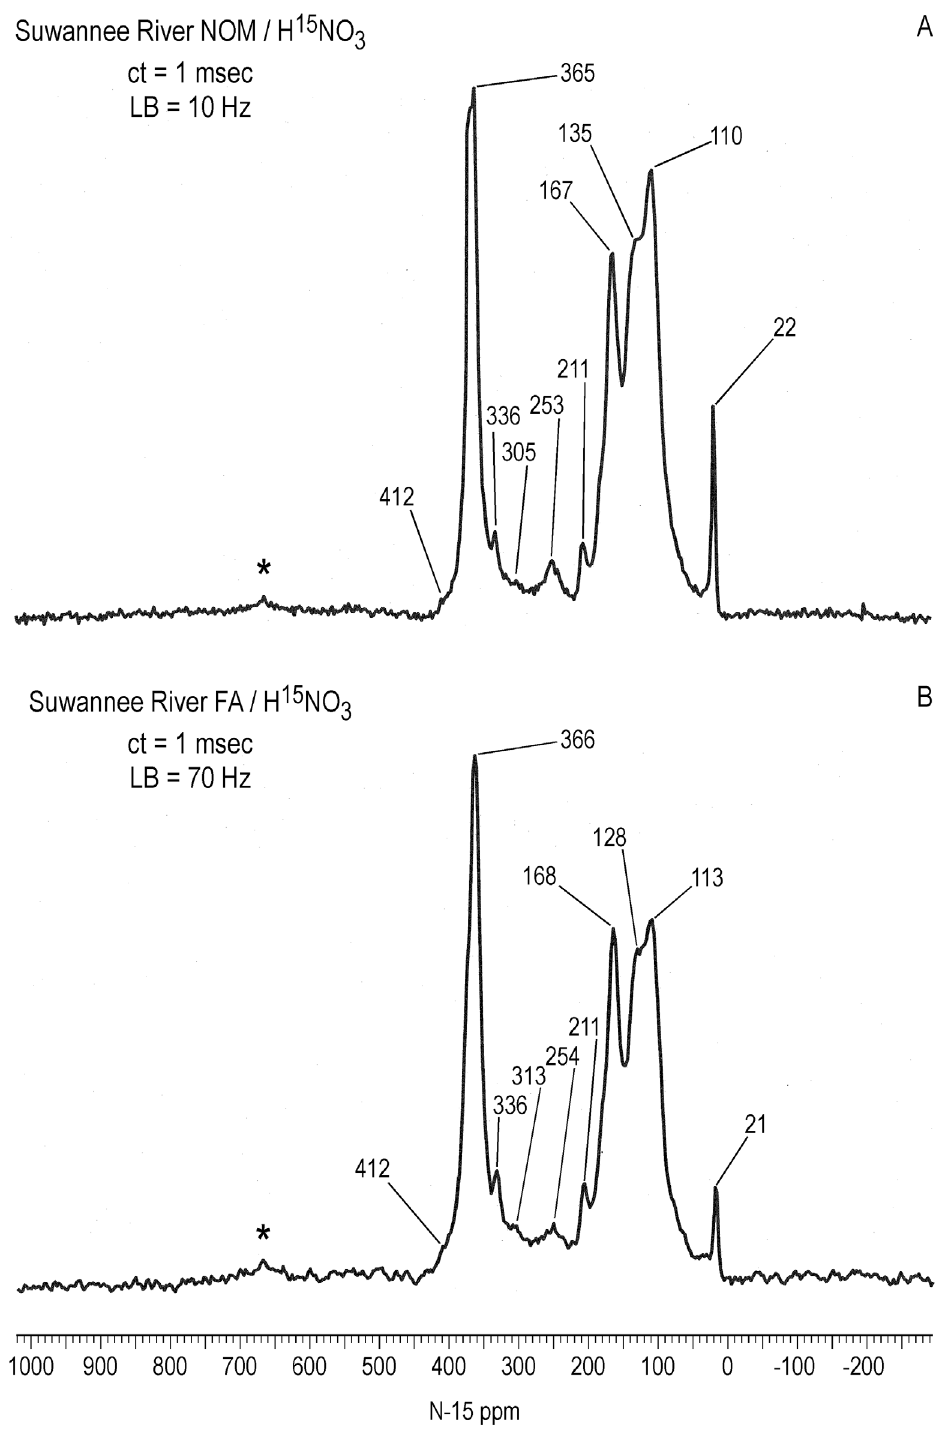
Fig 6. Solid state CP/MAS N-15 NMR spectra of Suwannee River NOM and SRFA treated with N-15 labeled nitric acid. ct = contact time. LB = line broadening. Spinning speed = 6 kHz. Asterisks denote spinning